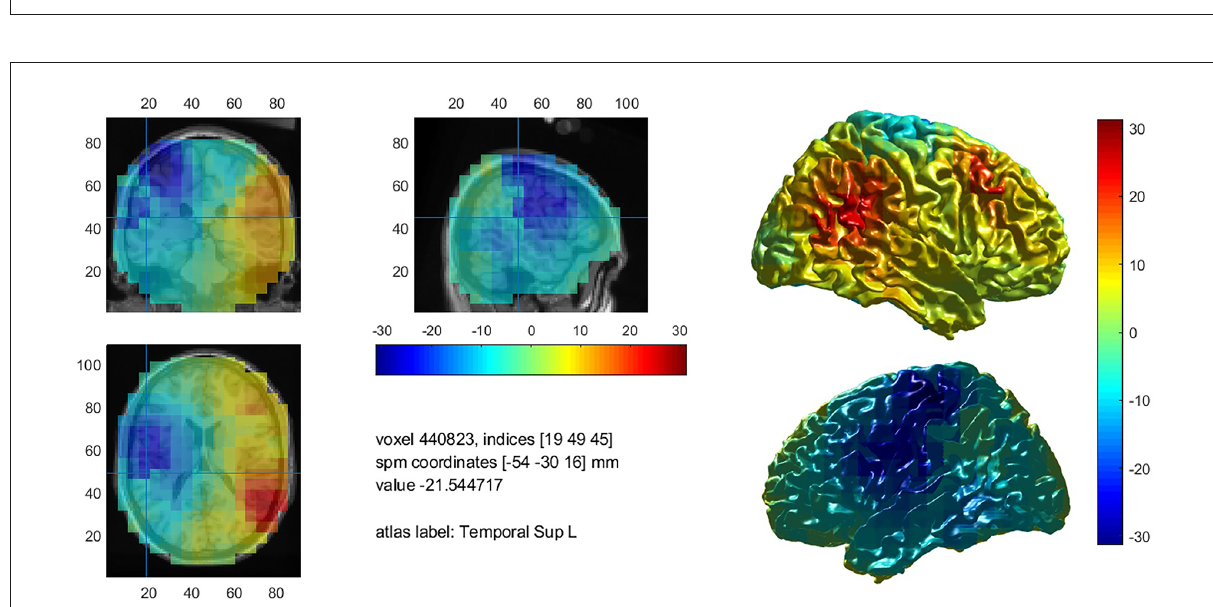
FIGURE4 Mean decrease of beta band activity within the left hemisphere in controls.